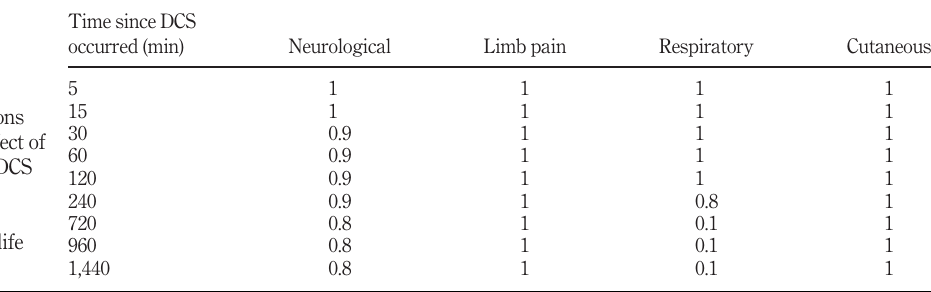
survival functions determining effect of suffering each